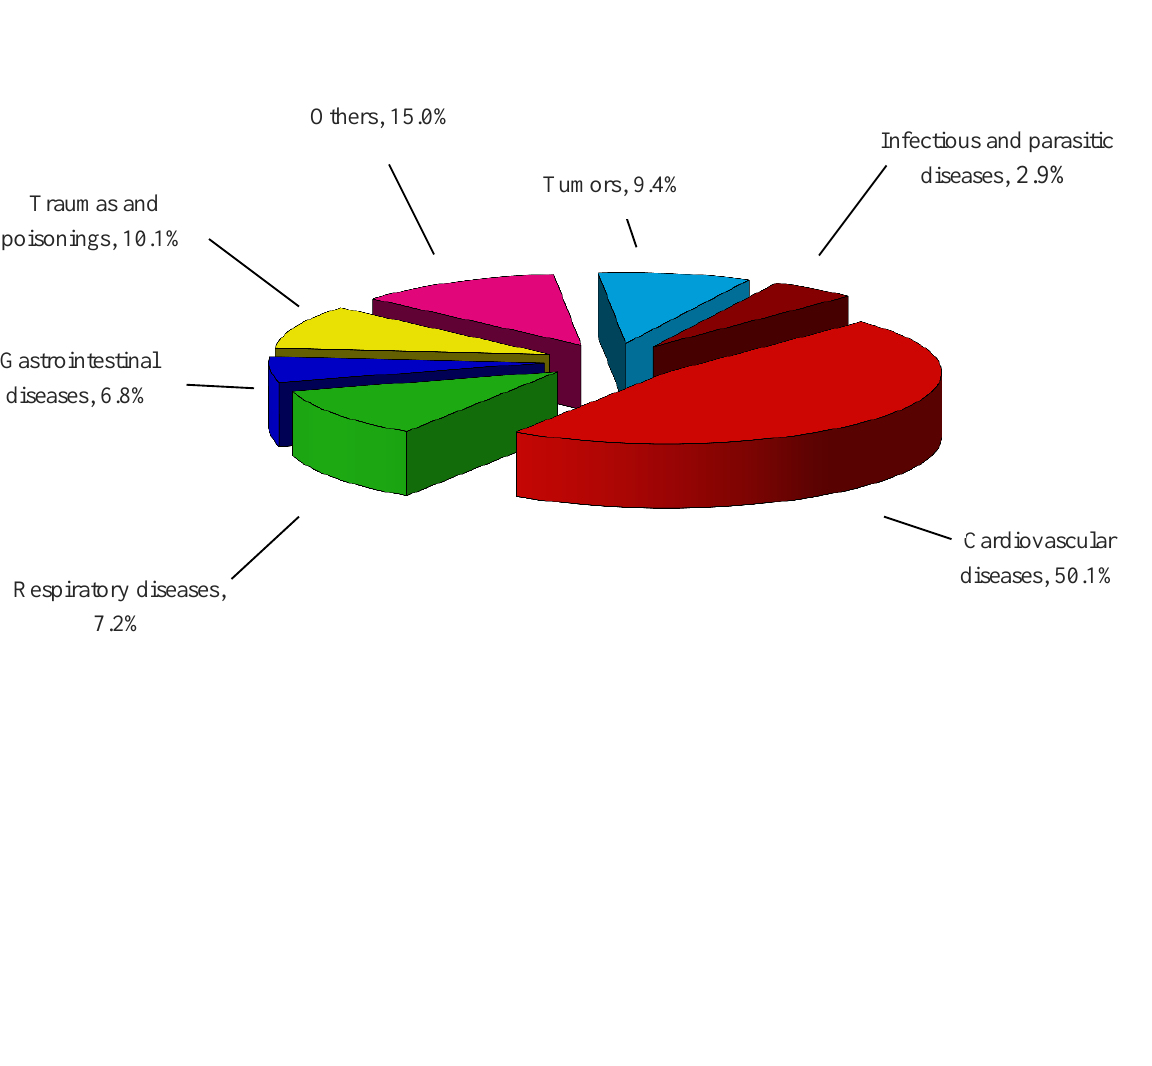
Figure 1: The structure of the reasons of death rate of the Kyrgyz Republic population (according to Republican medical and informational centre,